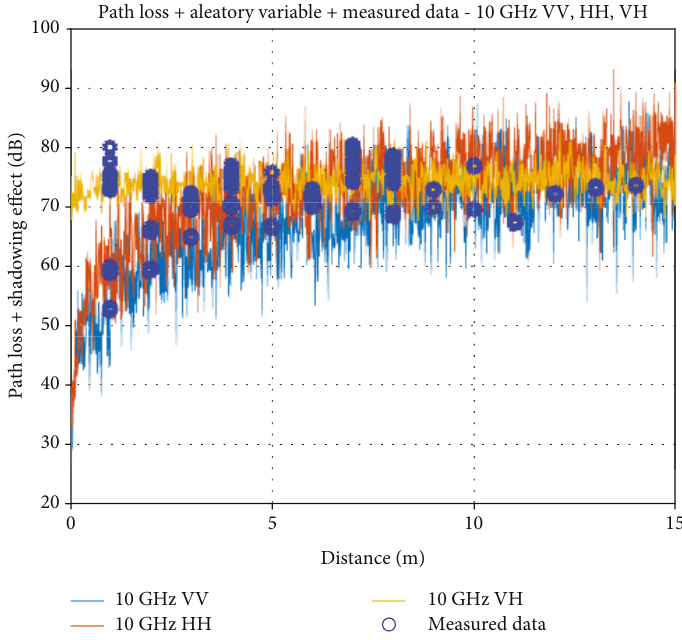
Figure 4: Path loss model CI with shadowing e ff ect at measured data for 10GHz band in corridor